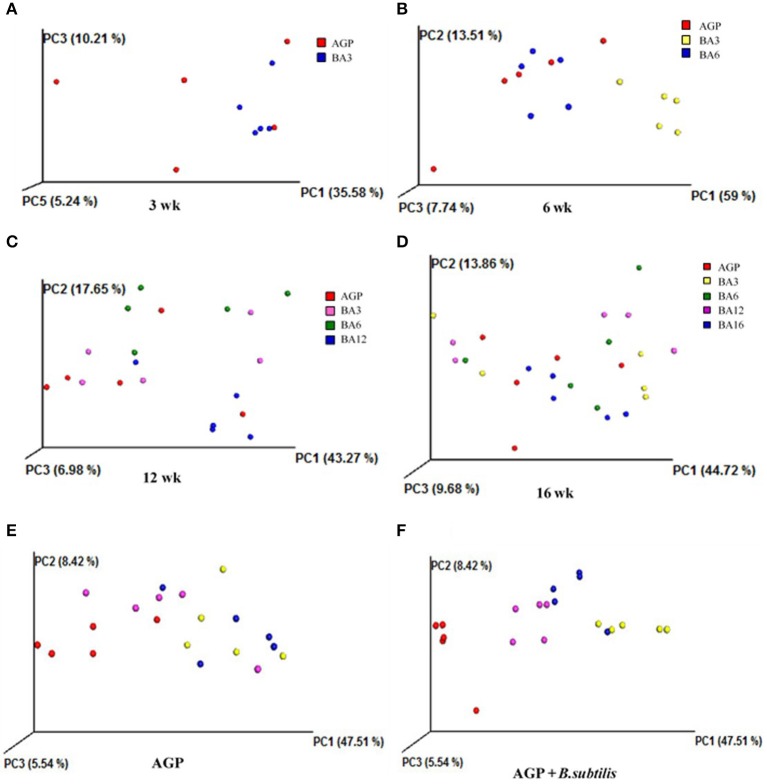
Principal component analysis (PCoA) plots based on treatments of pullets from 0 to 16 week-age. The plots represent the samples, and the different colors represent treatments. (A) PCoA plots for treatments at week 3; (B) PCoA plots for treatments at week 6; (C) PCoA plots for treatments at week 12; (D) PCoA plots for treatments at week 16; (E) PCoA plots in AGP group for bird ages; (F) PCoA plot in AGP + B. subtilis group for bird ages.